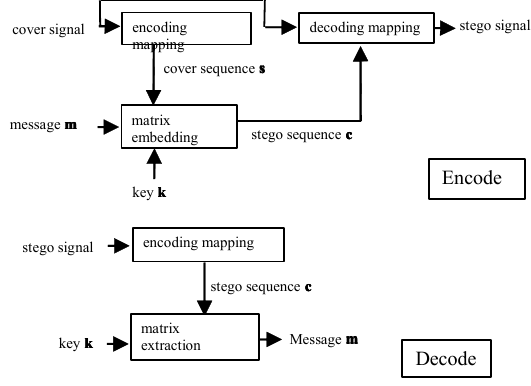
Figure. 1 information hiding system using matrix